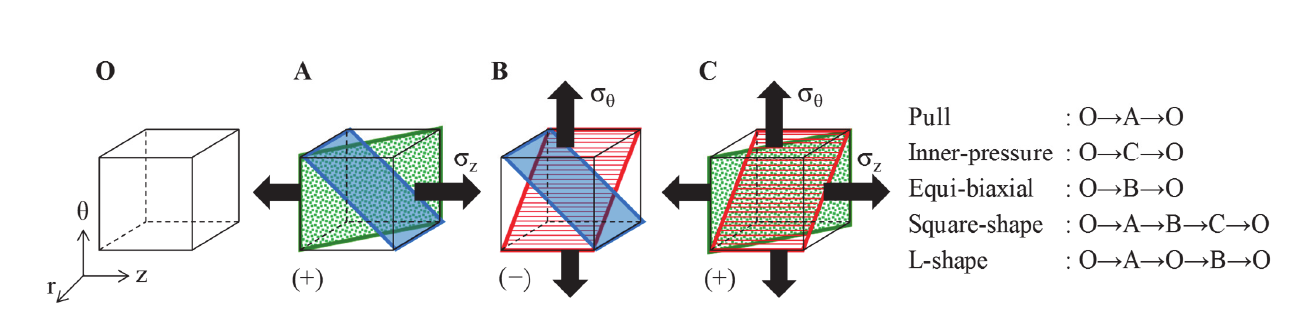
Figure 8: Schematic showing of slip planes at each loading condition.